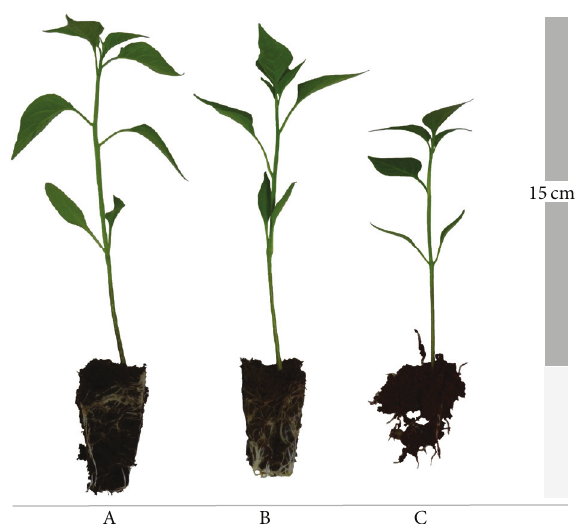
Figure 8: Characteristic chilhuacle chili seedlings and their root balls in three different substrates 50 days after planting. (A) Seedling developed in peat. (B) Seedling developed in common soil. (C) Seedling developed in volcanic gravel. Plants were irrigated every other day with 25% Steiner’s nutrient